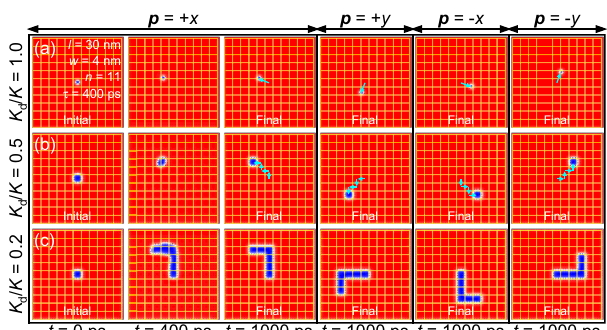
Fig. 2 Current-induced dynamics of a square-shaped skyrmion on the grids. a Top views of the current-induced motion of an ordinary round- shaped skyrmion in a sample with K d / K = 1 for different spin polarization direction p . K and K d stand for the perpendicular magnetic anisotropy constants for the unmodi fi ed areas and defect lines, respectively. The side length of the sample equals 378 nm. An ordinary skyrmion with the topological charge of Q = 1 is relaxed at the sample center as the initial state at t = 0 ps. A 400-ps-long current pulse of j = 100 MA cm − 2 is applied, and then the system is relaxed for 600 ps. Here the damping parameter α = 0.3. b Top views of the current-induced hopping motion of a square-shaped skyrmion in a sample with defect lines for different p . Here, l = 30 nm, w = 4 nm, n = 11, and K K = 0.5. l denotes the spacing between d / two adjacent parallel defect lines. w denotes the width of the defect line. n denotes the number of unit square patterns along the x and y directions. The side length of the sample equals 378 nm. A square-shaped skyrmion with Q = 1 is relaxed at the sample center as the initial state at t = 0 ps. A 400-ps-long current pulse of j = 100 MA cm − 2 is applied, and then the system is relaxed for 600 ps. The defect lines with reduced K d are indicated by yellow lines. The motion route is denoted by the cyan arrow. c Top views of the current-induced deformation of a square-shaped skyrmion in a sample with defect lines for different p . Here K d / K = 0.2. The other parameters are the same as those in ( b